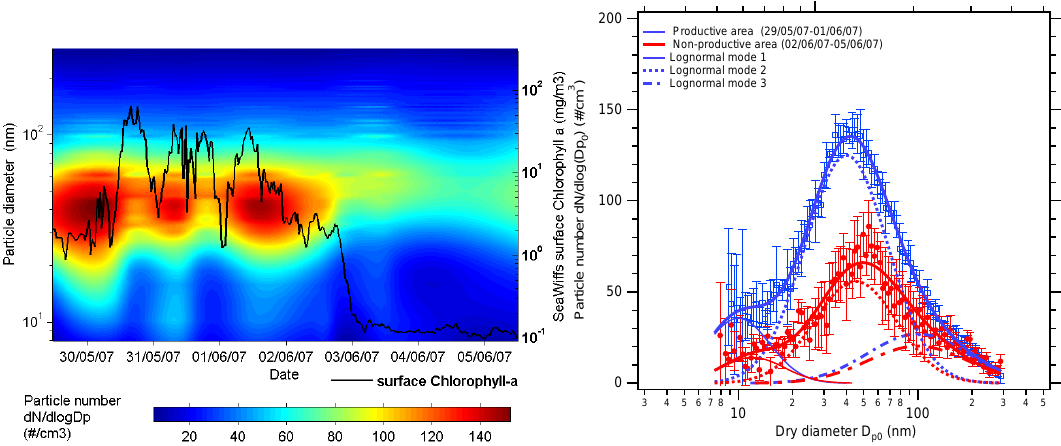
Fig. 12. Evolution of the size distribution of primary aerosol generated by bubbling unfiltered seawater during the RHaMBLe cruise (29 th May- 5 June) and seawater chlorophyll- a concentration (derived from SeaWiffs ocean color data) along the cruise track (left). Mean particle size distributions measured inside and outside the productive area during the RHaMBLe cruise (right) and decomposition into log- normal modes. Measurements were conducted at ∼ 23 ◦ C. Error bars indicate the variability of the measurements obtained from 6 scans during 1 h period as ± 1 σ standard